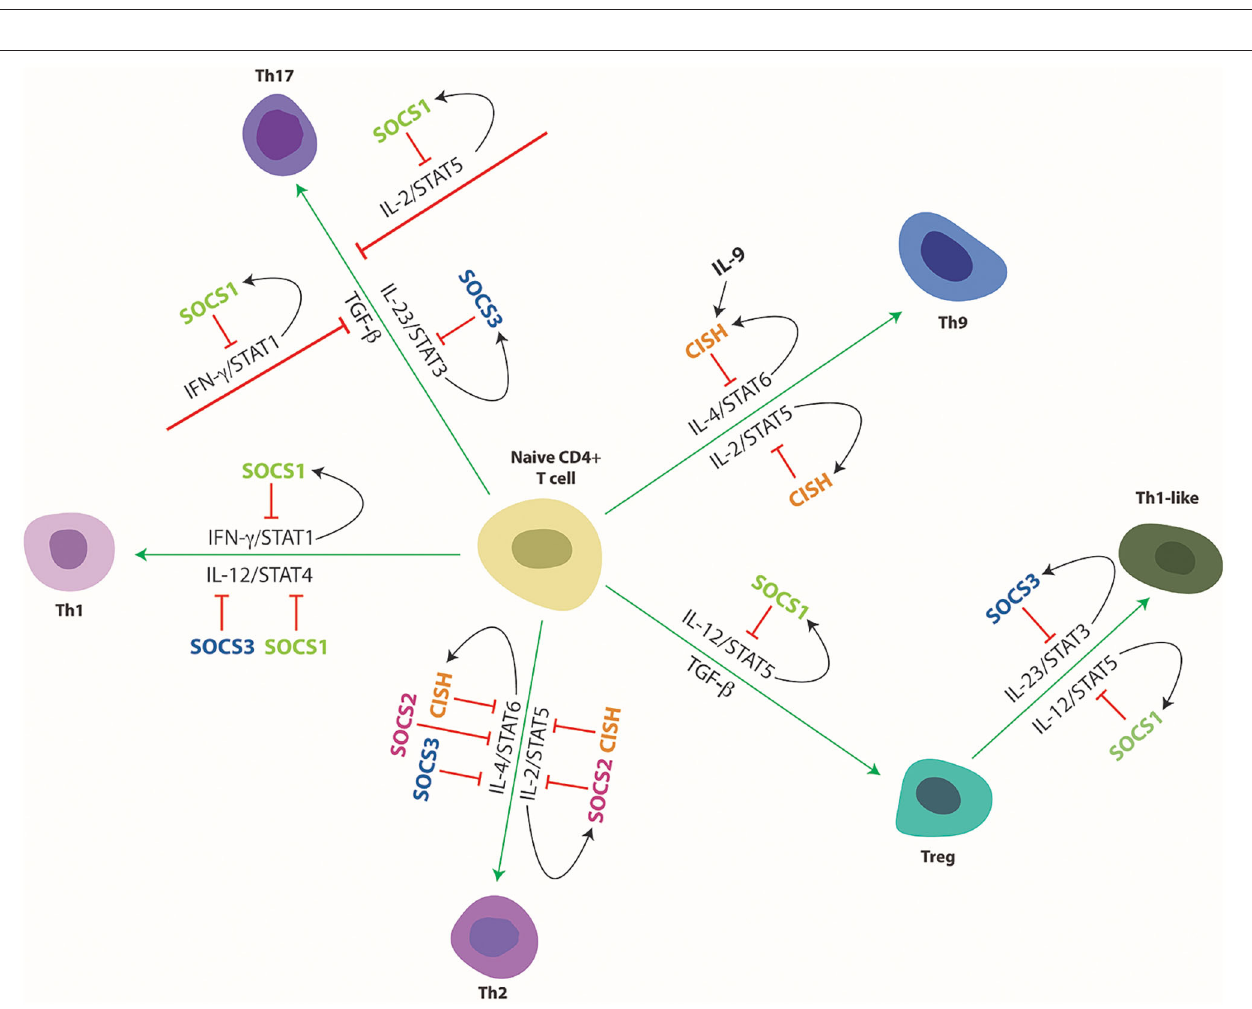
FIGURE 3 | phosphorylated target proteins such as receptor-associated JAK proteins (left) or receptors themselves (right), subsequently assembling components of the E3 ubiquitin ligase complex: elongins B and C binding to the BC box and Cullin 5 binding to the Cul box located within the SOCS box. Other components of the complex such as Rbx2 and E2 are assembled through interactions with Cullin 5. Ubiquitin molecules are transferred from the ligase to the target protein substrates, which signals their degradation along with that of associated proteins within the complex. (C) Inhibition of kinase activity. Both SOCS1 and SOCS3 utilize their SH2